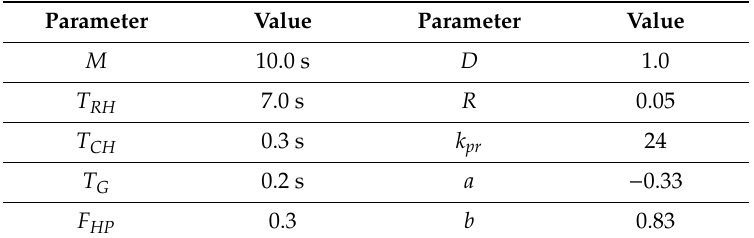
Table 1. System parameters mainly adopted from Reference [7].